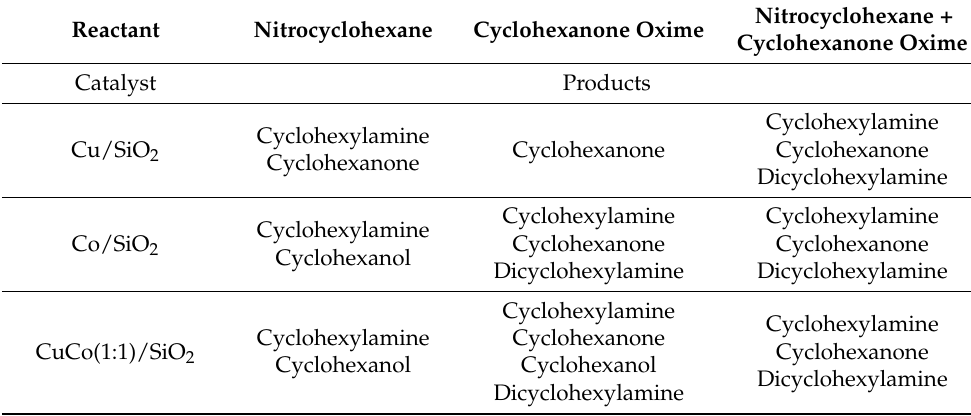
Table 2. Cu/SiO 2 , CuCo/SiO 2 , and Co/SiO 2 physicochemical